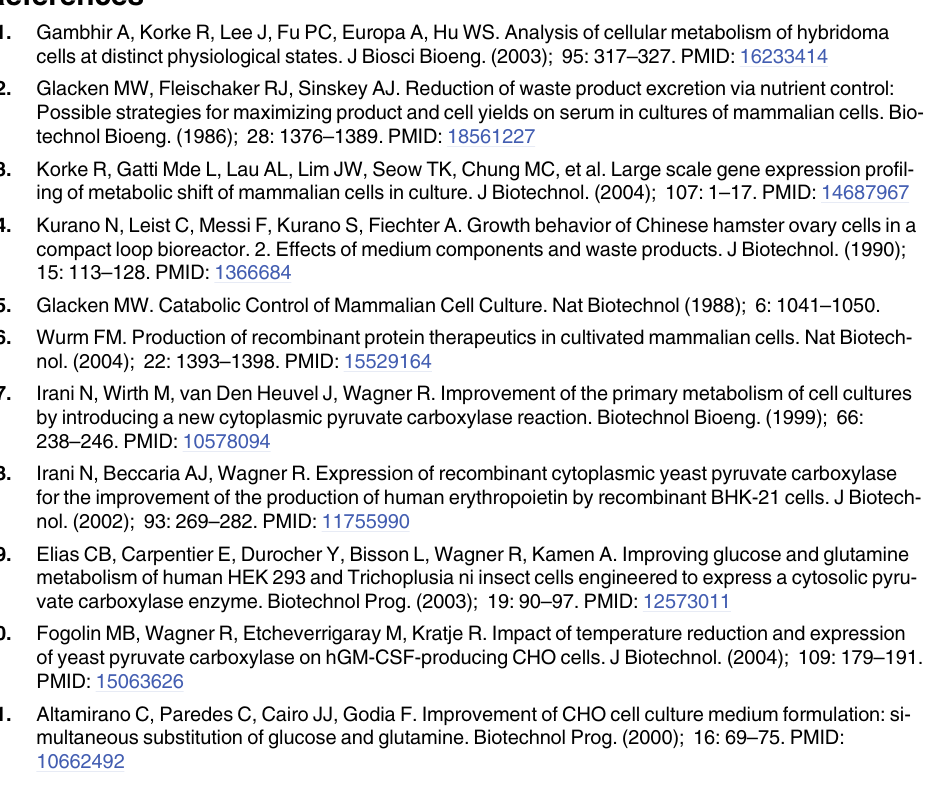
S1 Fig. Effect of the different modifications over redox state and its effect over protein as- sembly. Green and red text and arrows indicate an increase or decrease in pathway flux or mol- : Cytoplasmic NAD + ; NADH : Mitochondrial NADH; E.R.: ecule synthesis. NAD + CIT MIT Endoplasmic